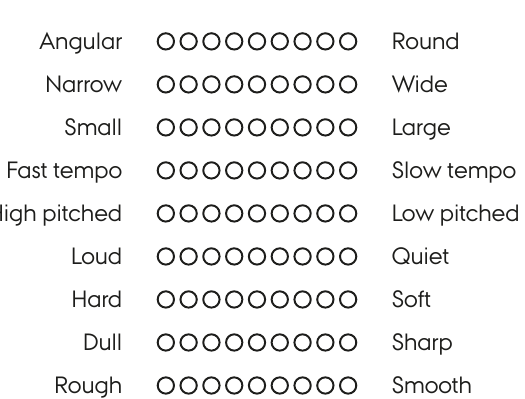
Figure 1. Metaphor pairs used in the coffee creativity study at the Sensory Summit US